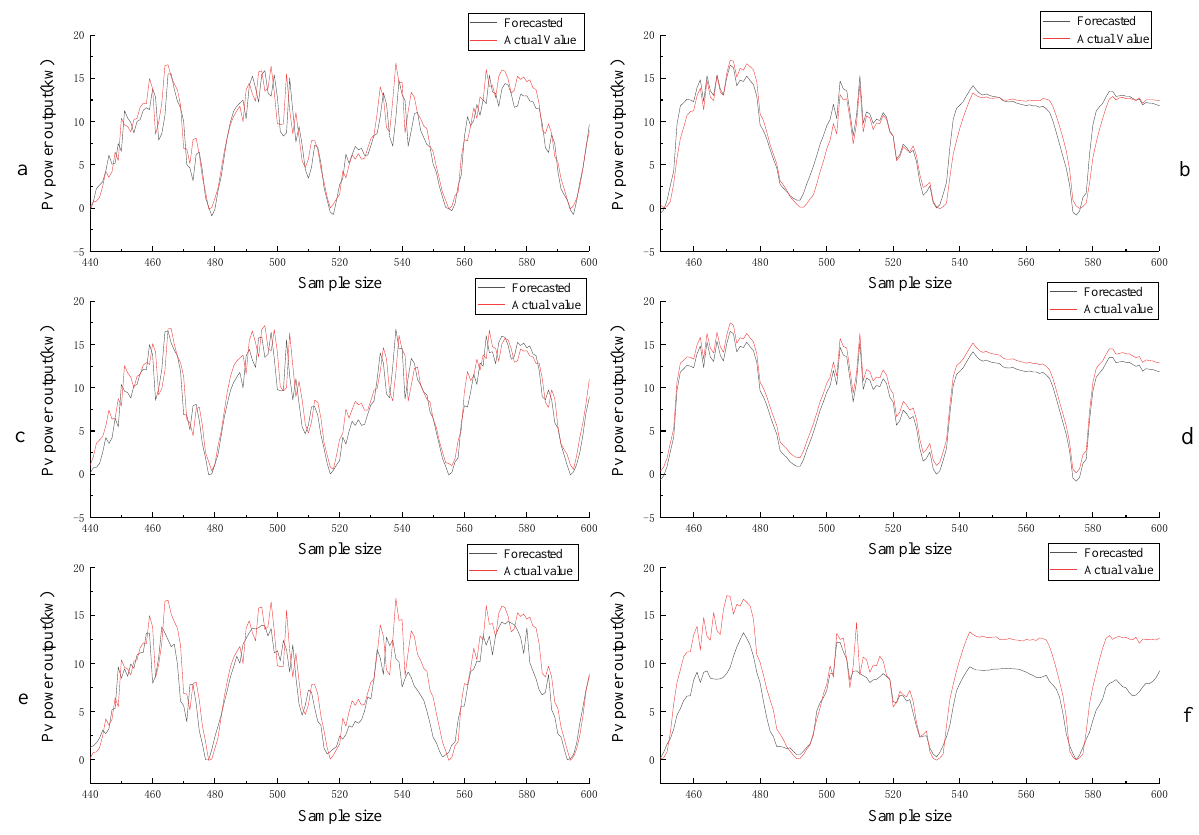
Figure 10. Multiple point prediction model diagram.